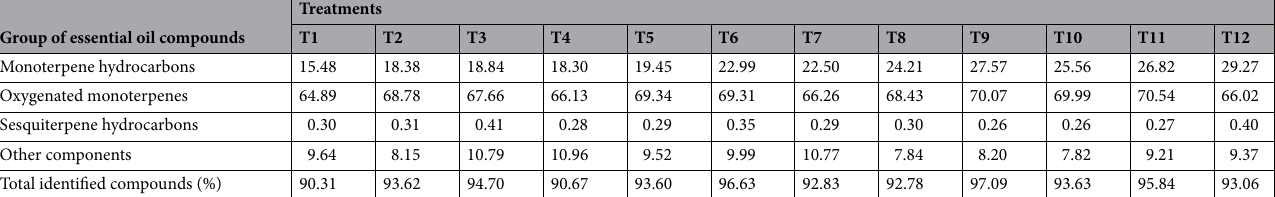
Table 4. Monoterpenes and sesquiterpenes percentage of coriander essential oil under the influence of organic and chemical fertilizers and humic acid (average of 2 years). T1 without fertilizer × without HA (control), T2 without fertilizer × HA before flowering, T3 without fertilizer × HA at the beginning of flowering, T4 vermicomposting × 0 HA, T5 vermicomposting × HA before flowering, T6 vermicomposting × HA at the beginning of flowering, T7 manure × without HA, T8 manure × HA before flowering, T9 manure × HA at the beginning of flowering, T10 chemical fertilizer × without HA, T11 chemical fertilizer × HA before flowering, T12 chemical fertilizer × HA at the beginning of flowering.